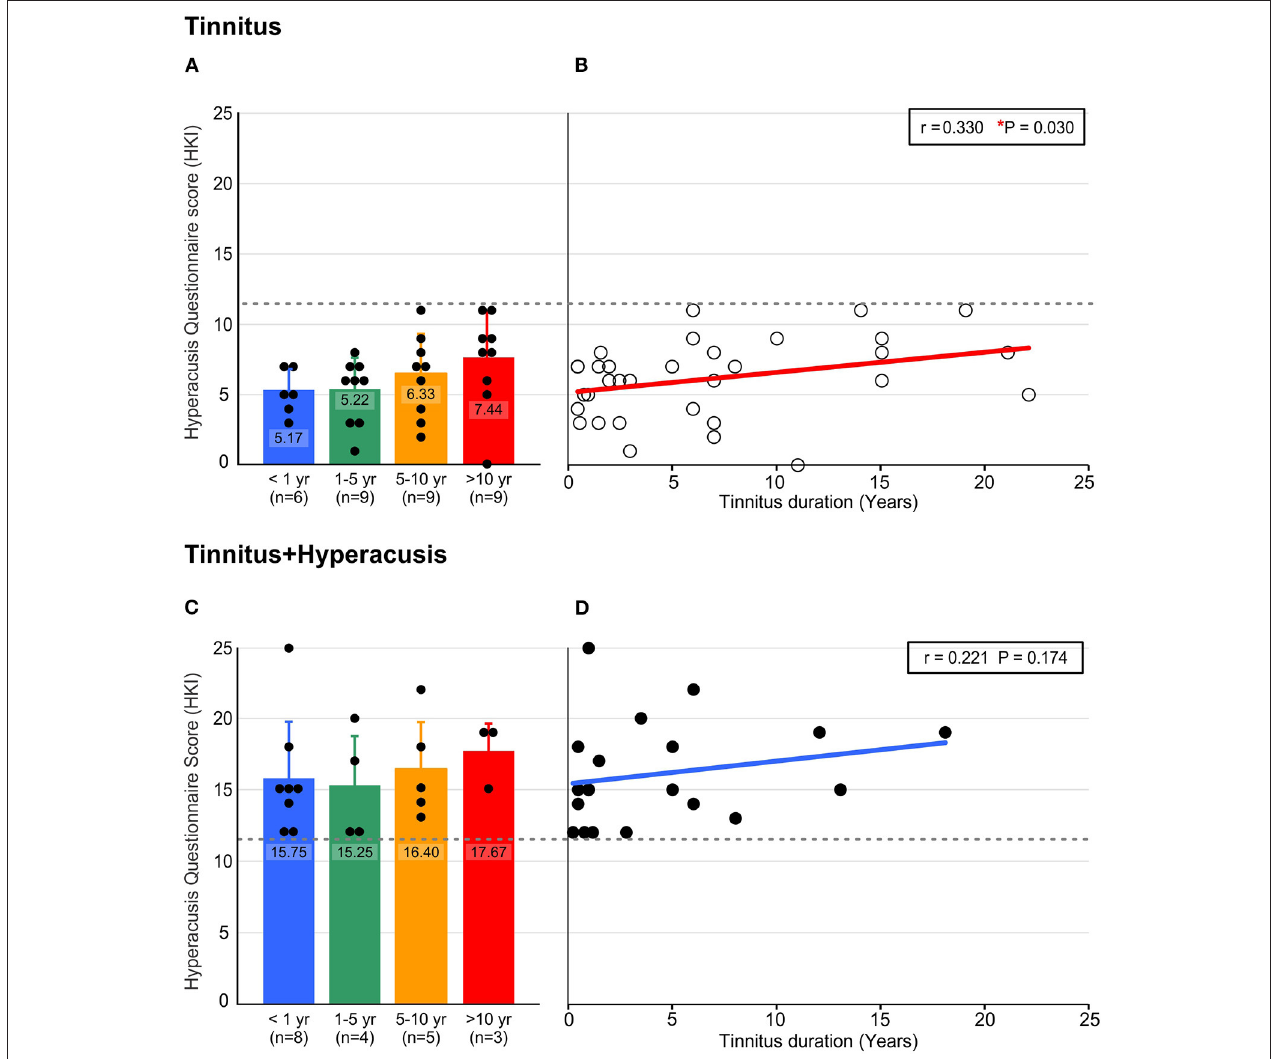
FIGURE 4 | Hyperacusis percept significantly increases in the participants with tinnitus with the longer persistence of their tinnitus (duration in years), determined by Hyperacusis Questionnaire score (HKI). (A) Tinnitus participants classified according to their tinnitus duration did not reach the criterion for being classified as hyperacusis suffering (HKI < 12), but reached higher scores with the longer persistence of their tinnitus. (B) Linear trend over time of tinnitus duration suggests a significant increase of affection by hyperacusis with tinnitus duration ( P = 0.03, n = 33). (C) Participants with tinnitus and classified as hyperacusis sufferers (HKI ≥ 12) experienced continuing hyperacusis over the duration of their tinnitus. (D) The hyperacusis in the tinnitus + hyperacusis participants followed a trend of hyperacusis reinforcement with tinnitus duration, though this was not statistically significant ( P = 0.174, n = 20). Data in A, C show mean ± SD. r correlation coefficient, * P < 0.05, HKI; Hyperacusis